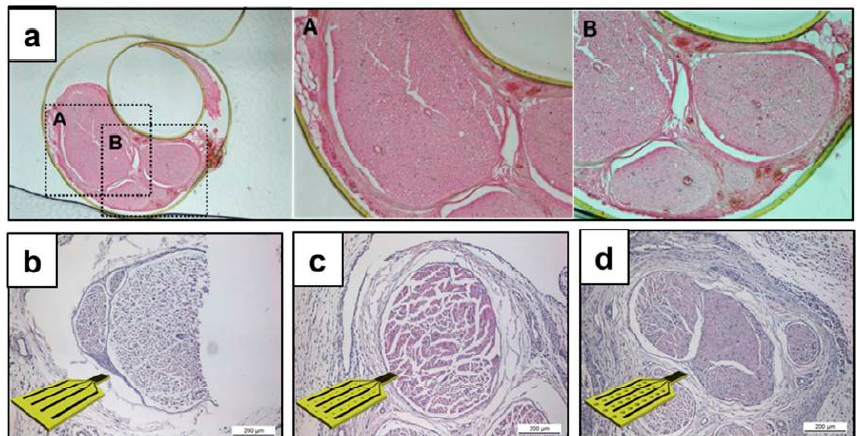
Figure 14. Histological images of nanofiber, polyimide (PI1338)-based electrodes after implantation in the sciatic nerve of a rat: ( a ) pristine electrode straight after implantation ( A , B ) magnifications of the contact area between tissue and electrode); ( b ) pristine electrode at 4 days post-implantation; ( c ) electrode with small holes at 4 days post-implantation; ( d ) electrode with large holes at 4 days post-implantation. Reproduced from [36], with permission from © 2017 American Chemical Society.